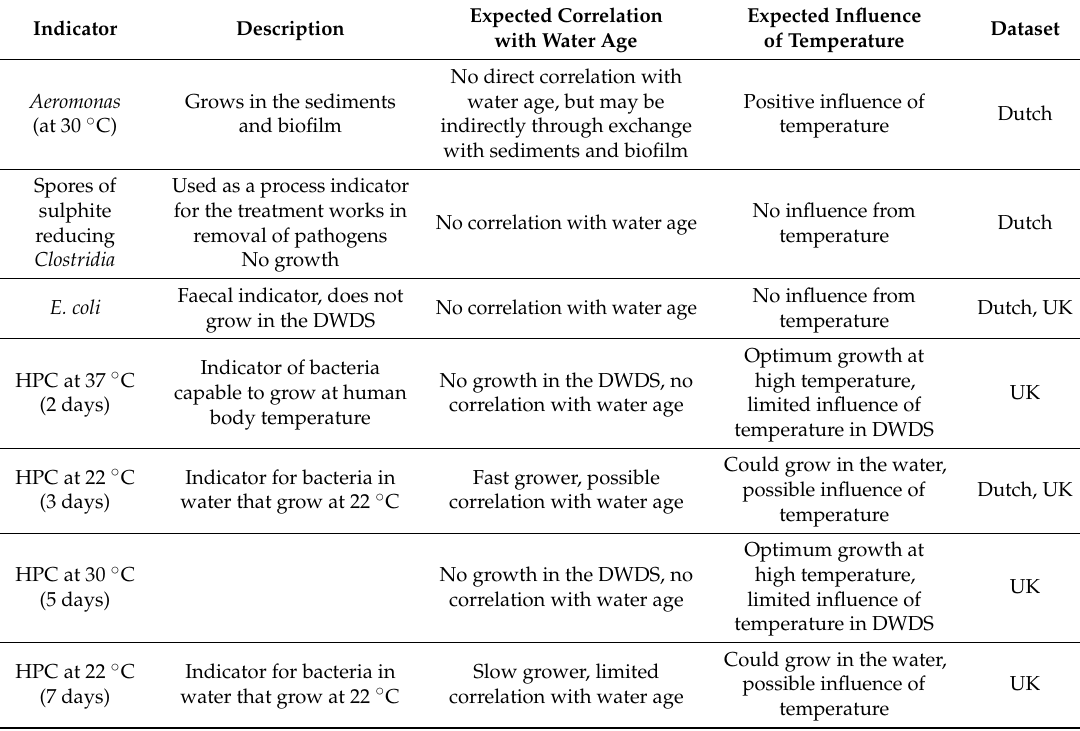
Table 1. Microbial parameters and influences.